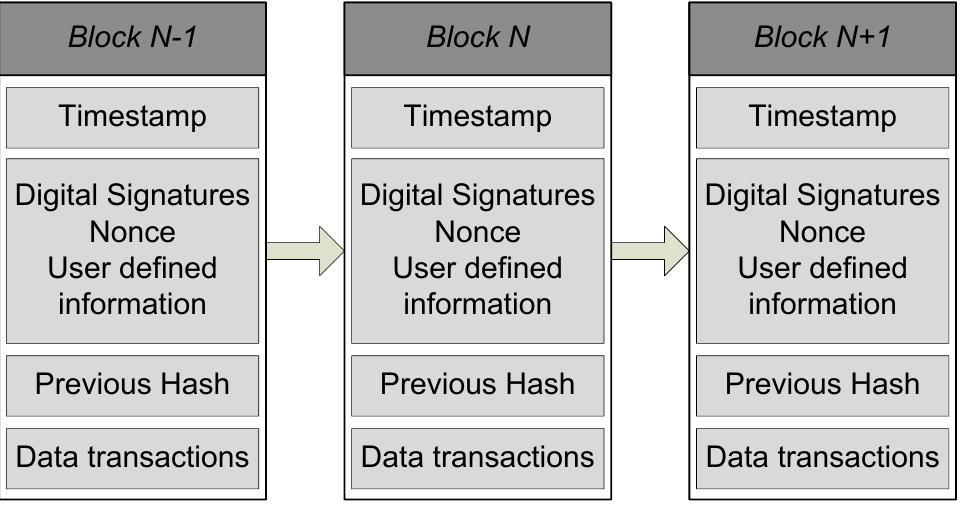
Figure 1. A standard blockchain